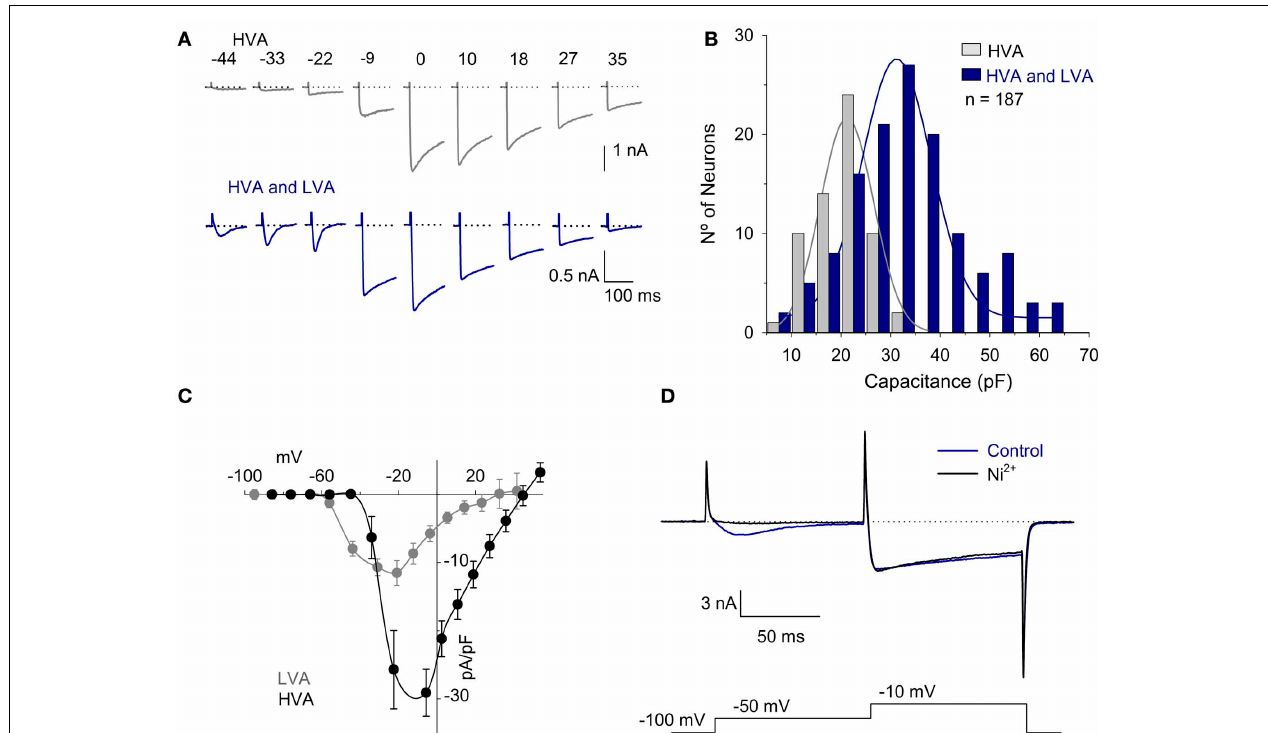
FIGURE 2 | HVA and LVA calcium currents in vestibular afferent neurons. (A) Representative traces of the I Ca produced by voltages between − 50mV and 30mV with a V H = − 100mV in neurons with HVA current and in those with both HVA and LVA currents. The dotted lines represent zero current. (B) Histogram showing the C m vs. the number of neurons. The neurons with both HVA and LVA I Ca (68%) are distributed across the range of C m from 9 to 62pF with a mean of 32 ± 1pF. The neurons with the HVA I Ca are distributed across the range of C m from 10 to 32pF with a mean of 20 ± 1pF. Continuous lines were fit with a normal function with R 2 > 0 . 95. (C) I-V